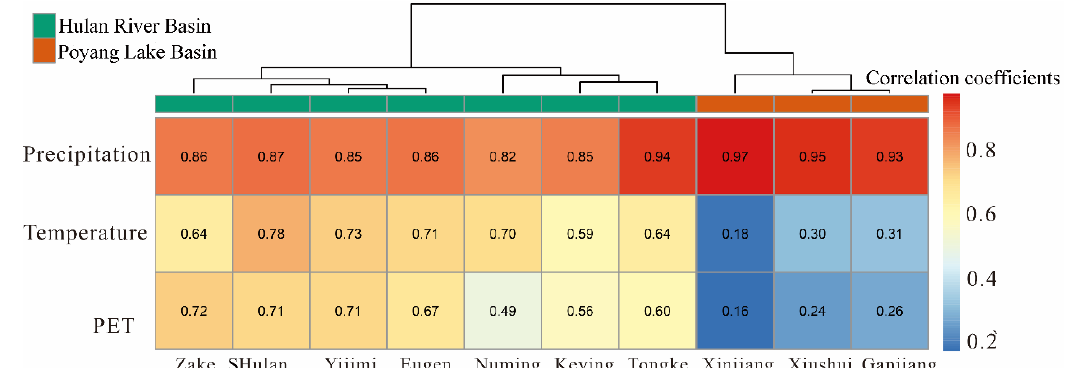
Figure 2. Monthly variation in precipitation, temperature, potential evapotranspiration, and runoff in the Hulan River Basin( a : monthly precipitation; b : monthly temperature; c : monthly potential evapotranspiration; d : monthly runoff).